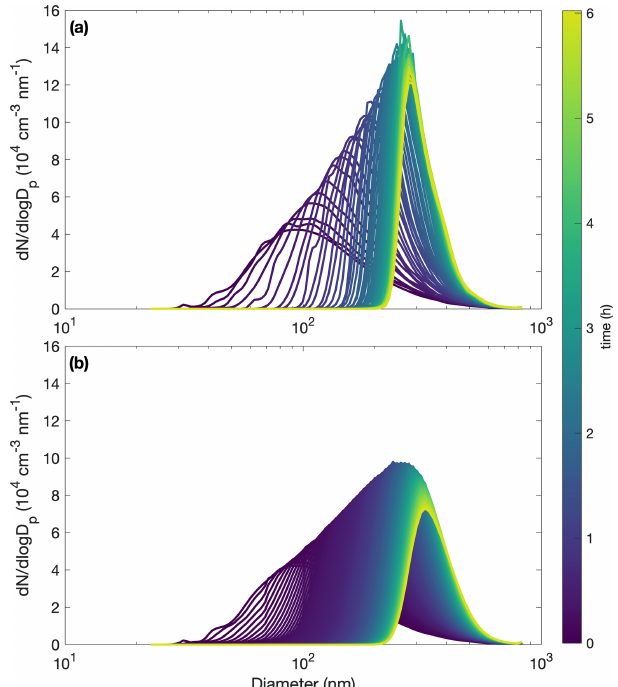
Figure C3. Comparison of measured (a) and simulated (b) parti- cle size distributions throughout oxidation for experiment R1. The decay of benzyl alcohol is represented using a second-order expo- nential fit to the data. The accommodation coefficient of vapor to suspended particles α p = 1. Also, α pw = 0 and C w = 1 × 10 4 µgm 3 . Computational time steps are taken as